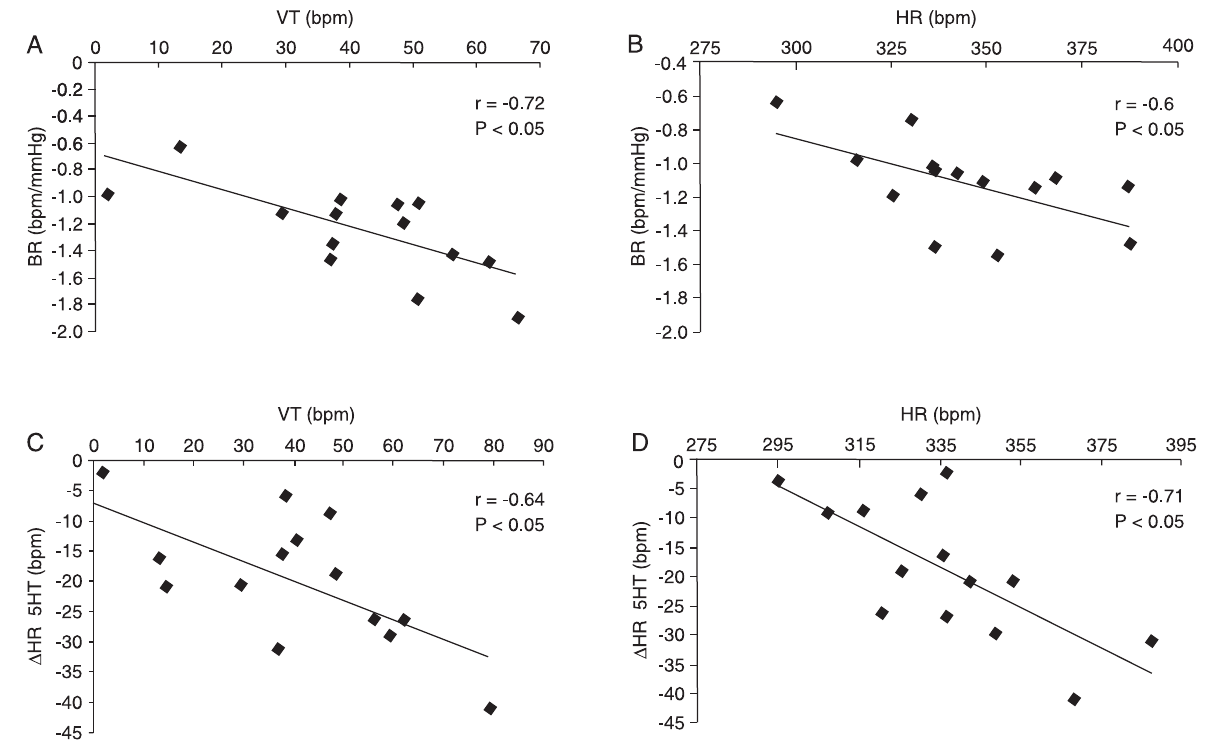
Figure 3. Correlations between (A) vagal tonus (VT) and bradycardic responses (BR) to falls in arterial pressure (r = -0.72, P < 0.05), (B) heart rate (HR) and BR (r = -0.6, P < 0.05), (C) VT and BR (ΔHR) to serotonin (r = -0.64, P < 0.05), and (D) HR and ∆HR to sero - tonin (r = -0.71, P < 0.05). 5HT = 5-hydroxytryptamine (serotonin). Correlations were determined by linear regression analysis of data for both sedentary and trained female rats.